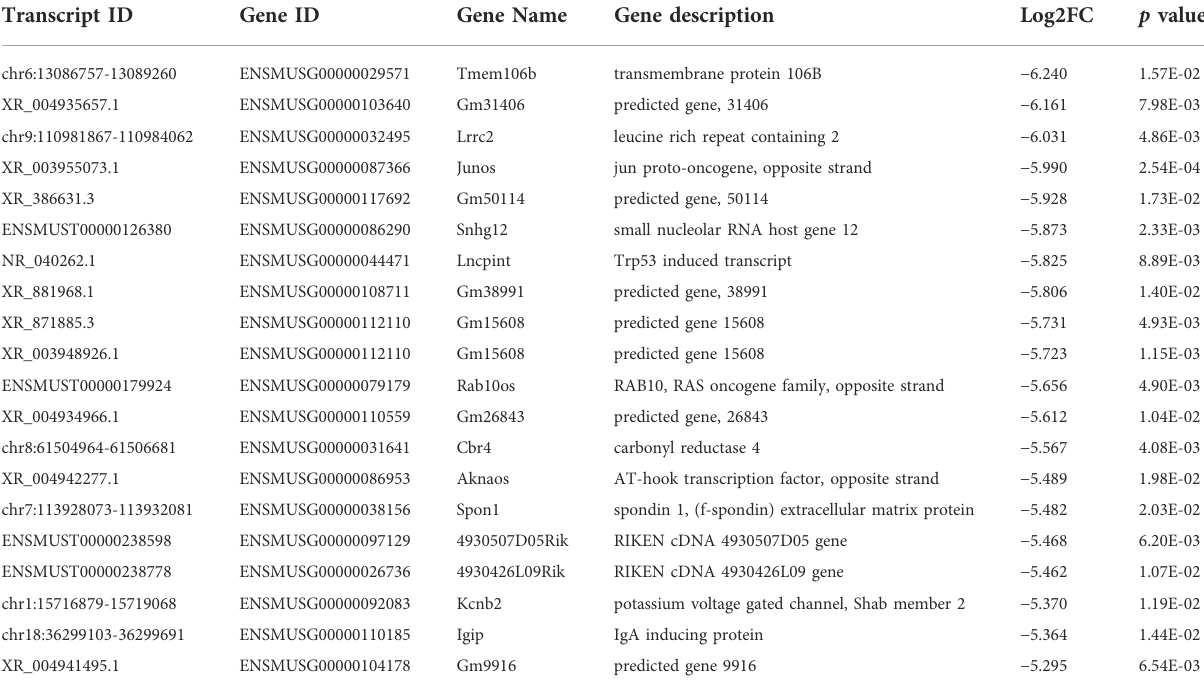
TABLE 2 Top 20 down-regulated LncRNAs ( p < 0.05) between FDM and fellow